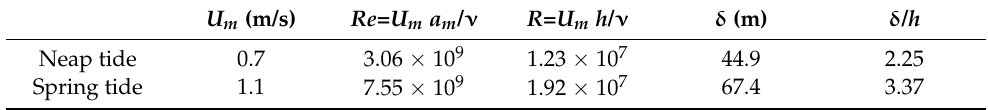
Table 3. Tidal flow conditions in the Rhine Estuary [32,58].